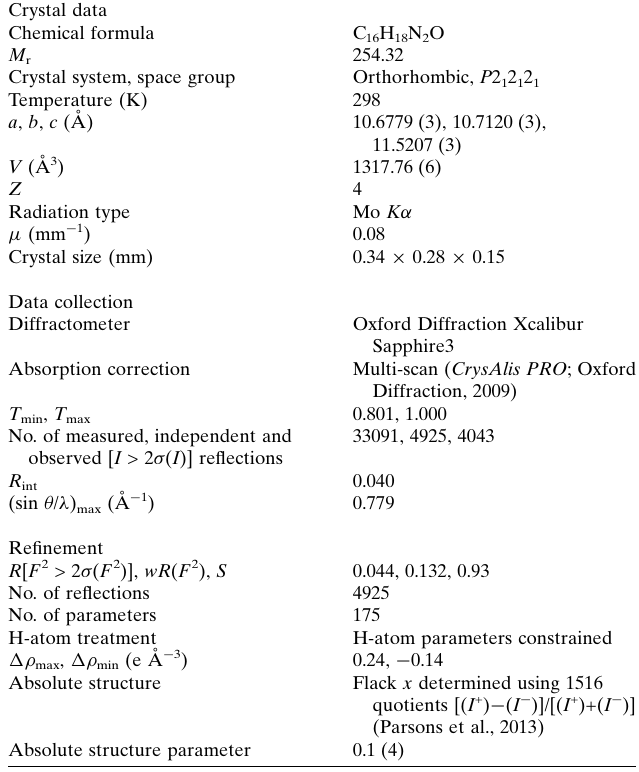
Table 1 Experimental details.